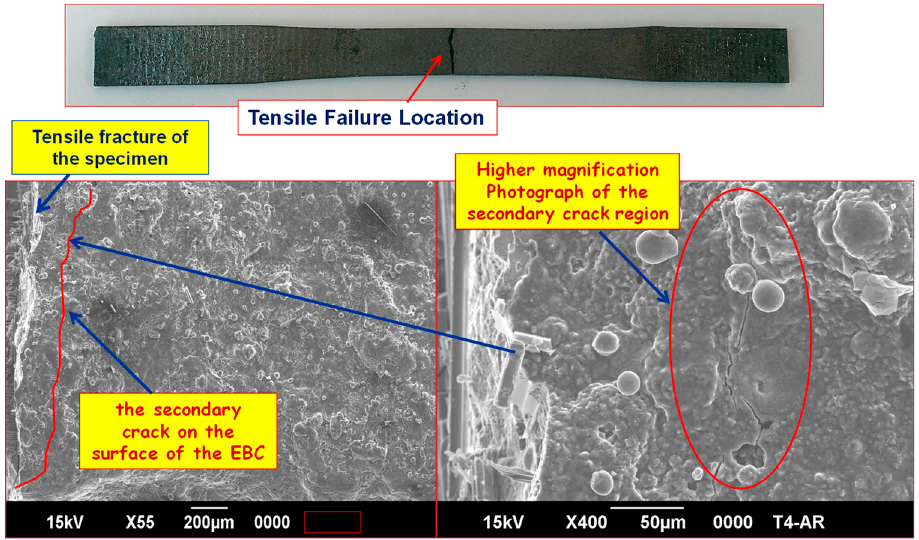
Figure 6. Failure mechanisms in EBC. Materials 2018 , 11 , x FOR PEER REVIEW